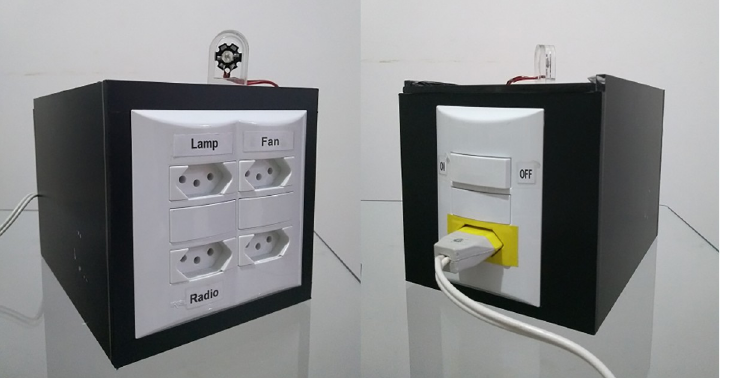
Fig 1. gBox: Electronic module to control home devices in the SE.